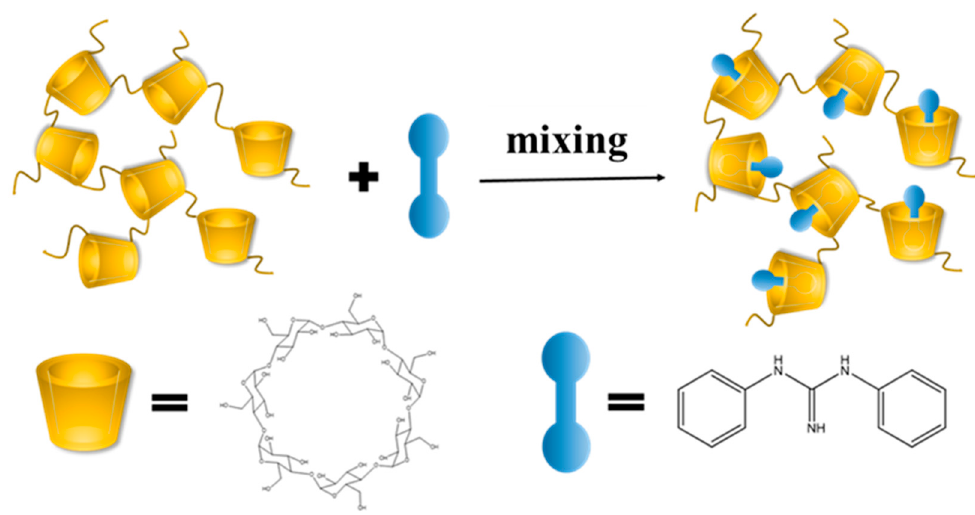
Figure 1. Schematic illustration of procedure for DPG- β -CDP.